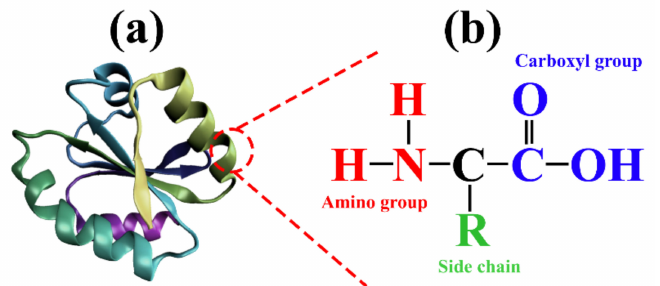
Figure 1. Chemistry of proteins. ( a ) 3D structure of protein molecule, and ( b ) abundance amino acid molecules in the protein